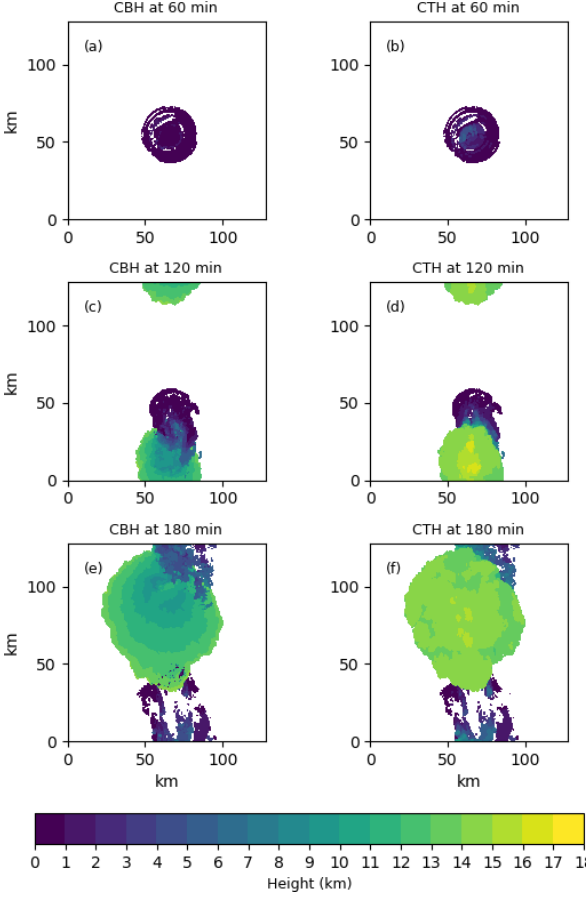
Figure 2. Cloud evolution. The cloud base height (CBH panels, a , c , and e ) and cloud top height (CTH panels, b , d , and f ) of the simulated convective cloud for the base case